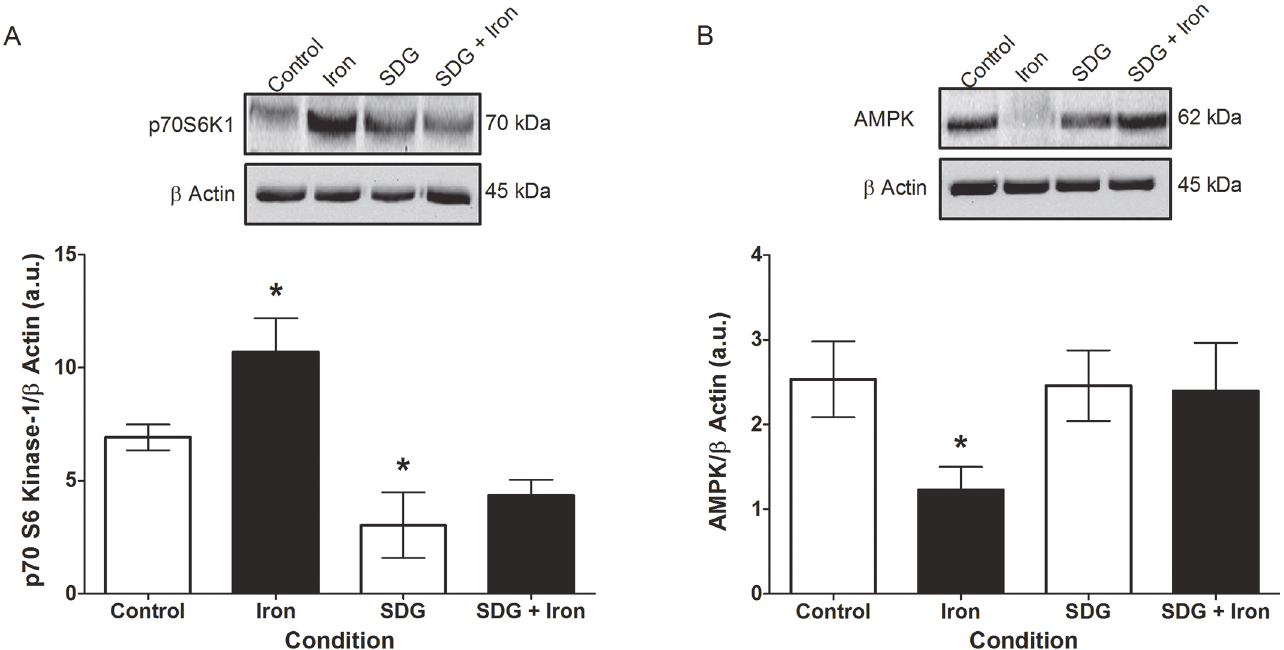
Fig 8. SDG decreases p70S6K1 and increases AMPK protein expression in iron treated H9c2 cells. p70S6 Kinase 1 (p70S6K1) (A) and AMP-activated protein kinase (AMPK) (B) protein levels in control, 50 μ M iron-treated, 500 μ M secoisolariciresinol diglucoside (SDG), and SDG pre-treatment + iron-treated H9c2 cells. Protein levels were measured via immunoblotting. Data is expressed as protein/ β -actin arbitrary units (a.u) ( * = p < 0.05 versus control, n =